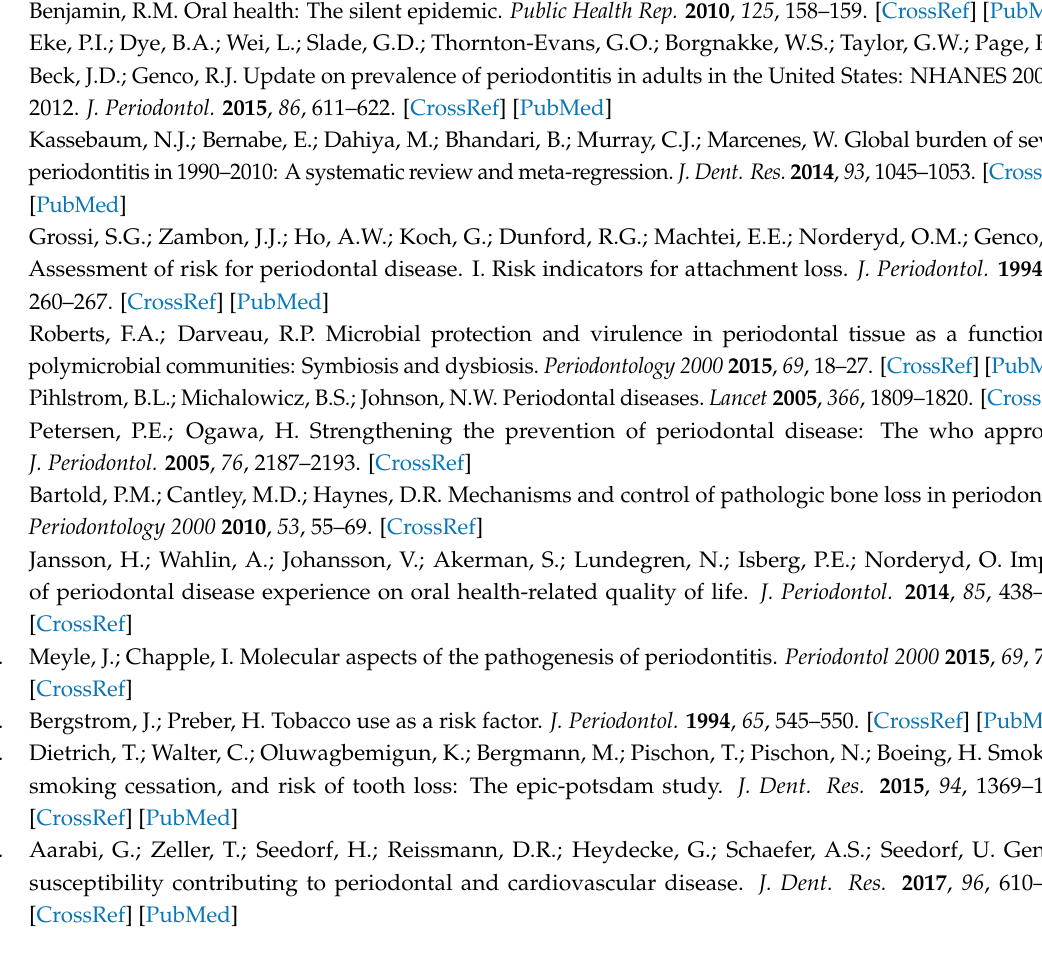
s1, Table S1: Population demographics, Table S2: Serum nutrient